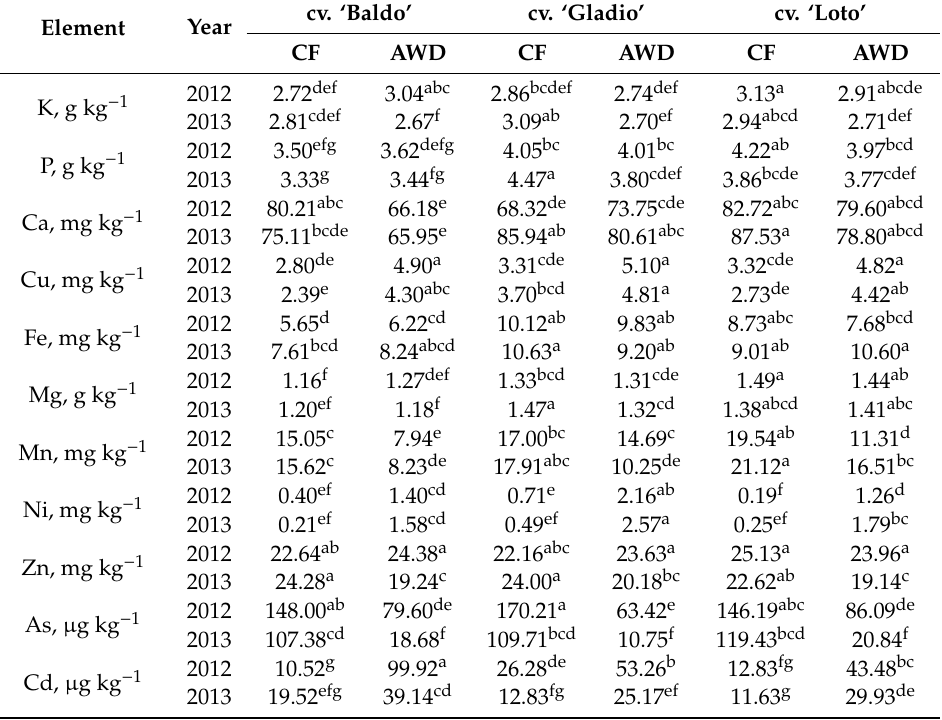
Table 6. Brown grain ionome of three rice cultivars grown under continuous flooding (CF) or alternate wetting and drying